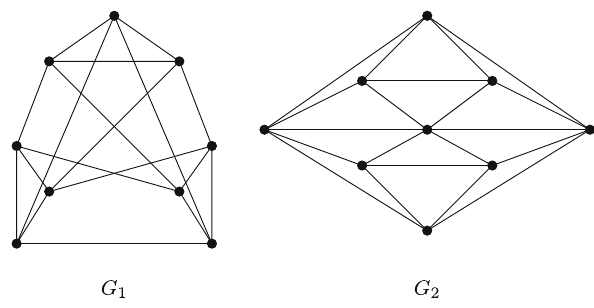
Figure 1: Two equienergetic graphs on none